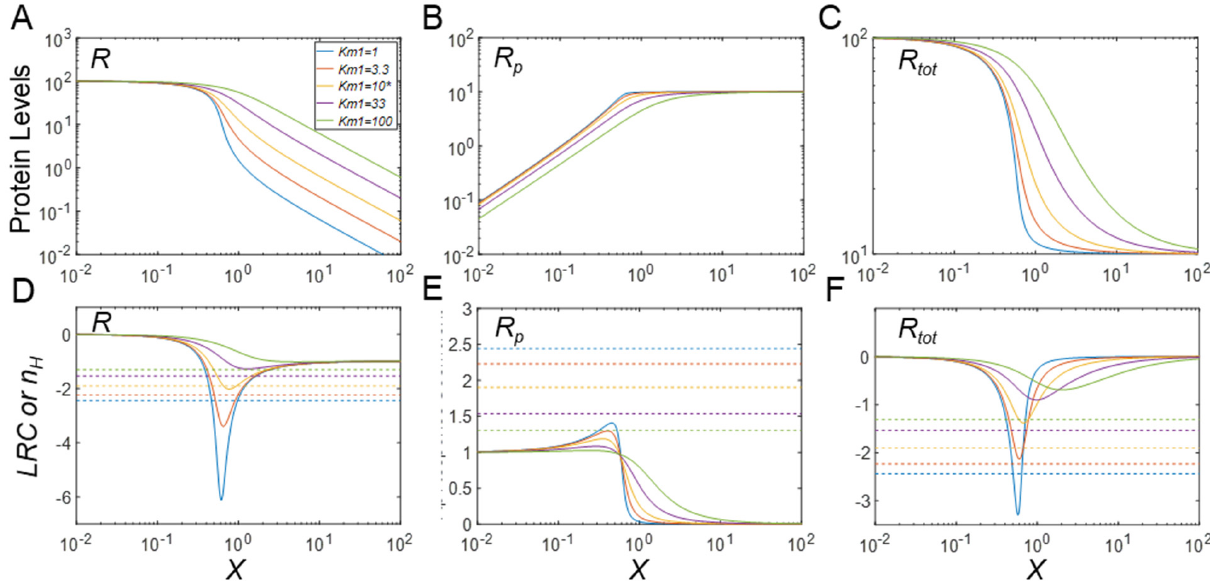
Figure 6. Effects of K m 1 on ultrasensitivity under phosphorylation-induced protein destabilization in the MM model ( k 4 = 0.1). ( A – C ) Steady-state DR curves for R vs. X , R p vs. X , and R tot vs. X , respectively, for different values of K m 1 , as indicated in A. The same color scheme for K m 1 values holds for all panels. The degree of ultrasensitivity increases for decreasing values of K m 1 . ( D – F ) LRC (solid lines) and n H (dashed horizontal lines) for R , R p , and R tot , respectively. * K m 1 = 10 is the default value.